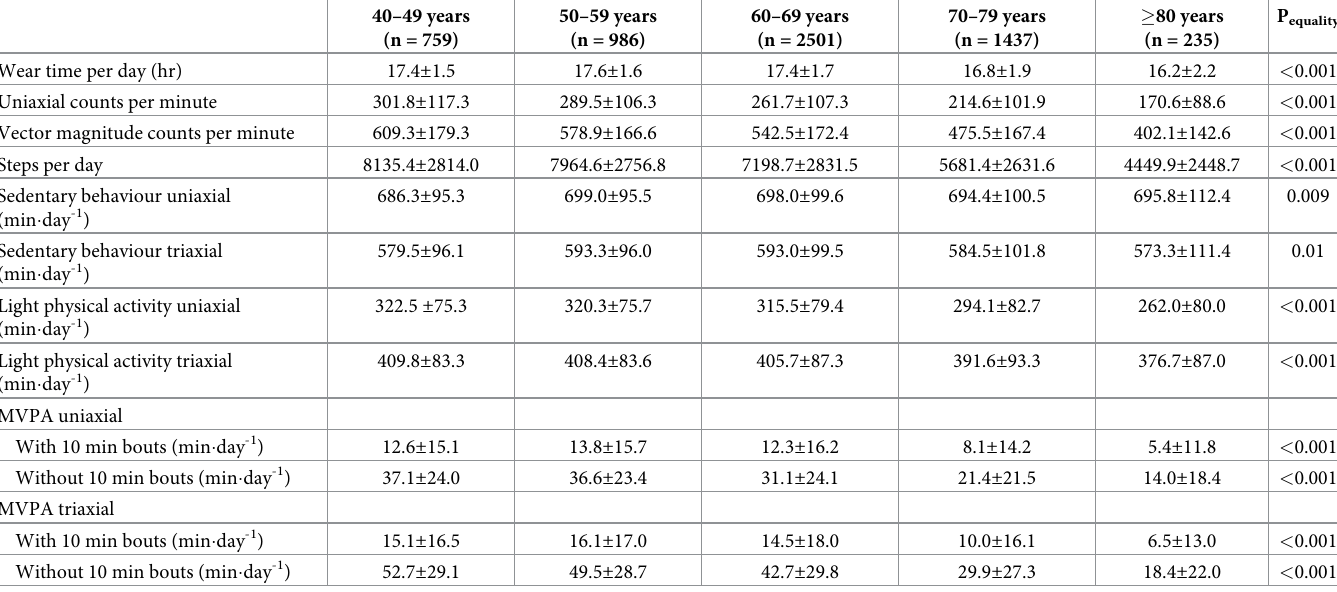
Table 4. Volume measures and intensity specific minutes per day by age groups. The Troms ø Study accelerometry sample 2015–16.